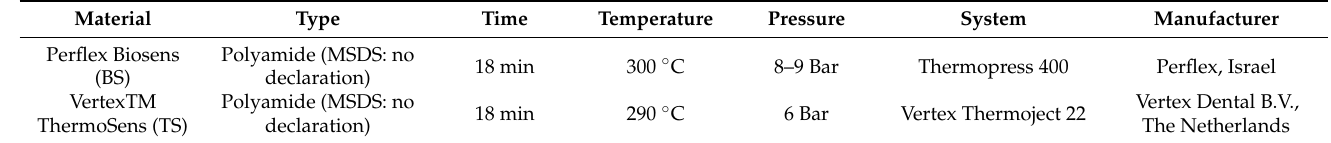
Table 1. Materials, technological parameters, and manufacturer.